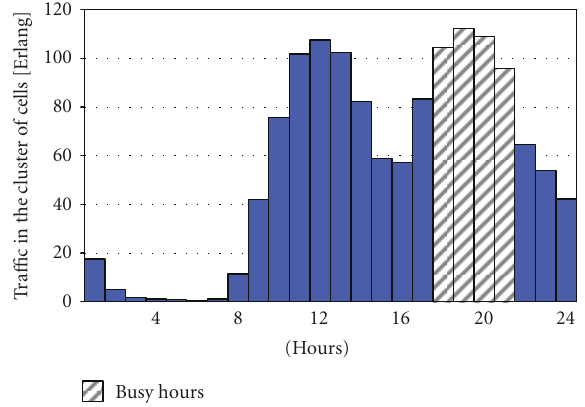
Figure 1: Daily tra ffi c in a cluster of 7 neighboring